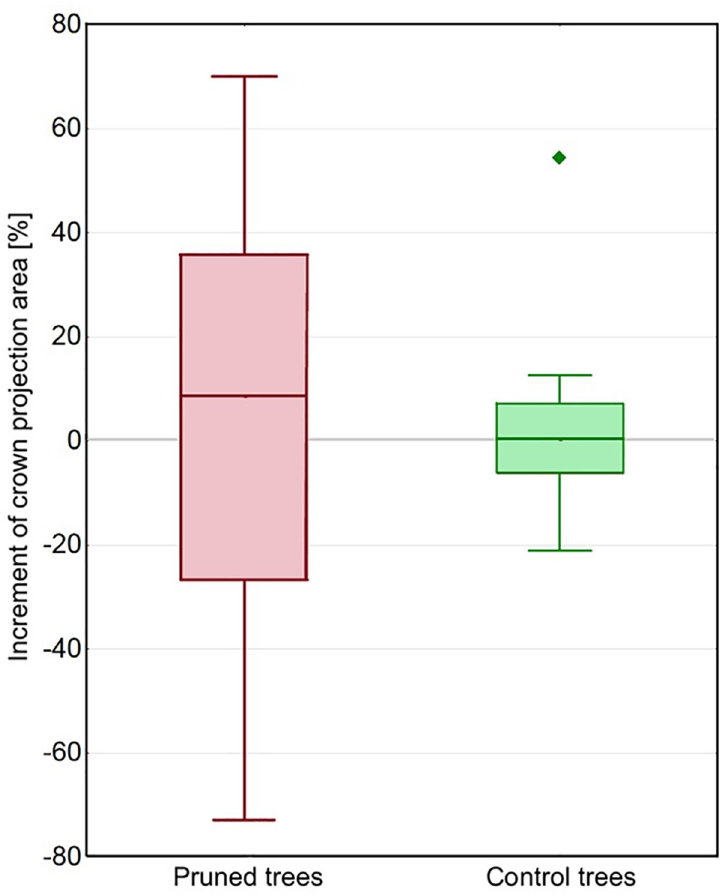
Fig 2. Increment [%] of the area of sight-based tree crown projections; medians, whiskers indicate variability outside the upper and lower quartiles.